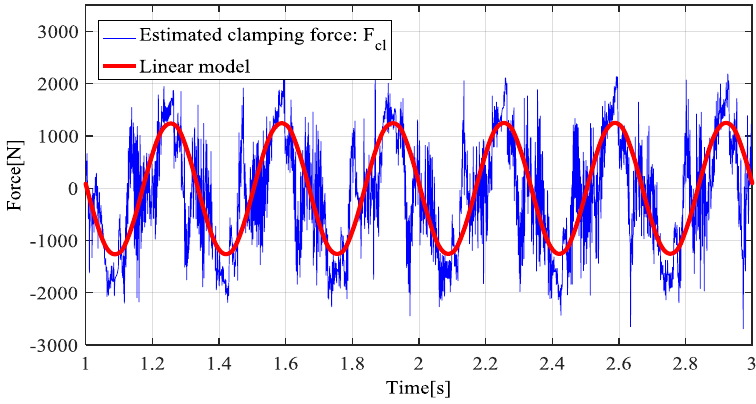
Figure 4. Results of system identification tests.